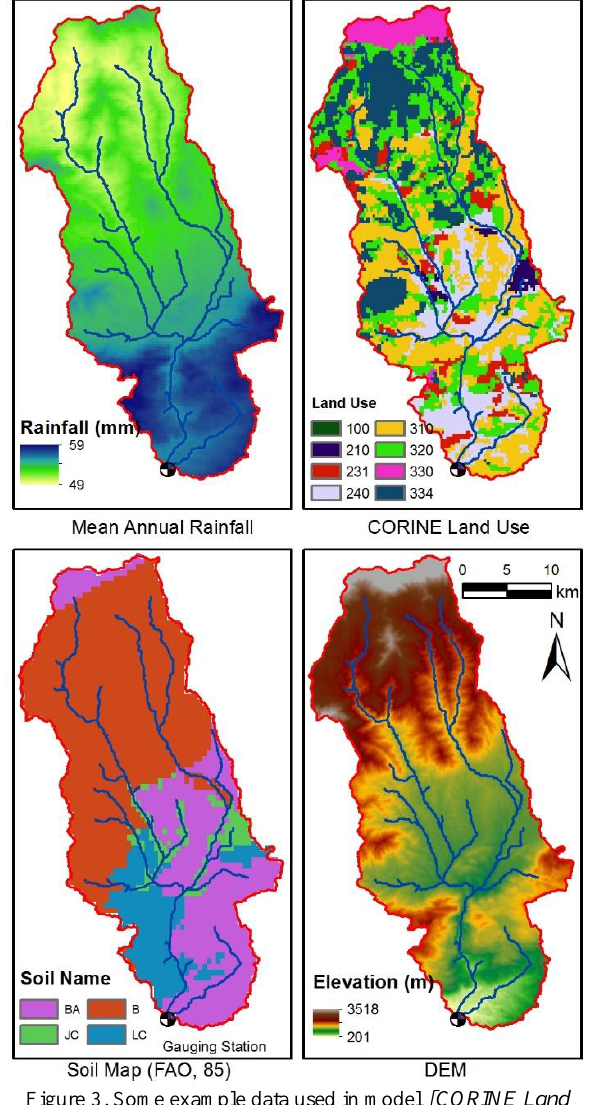
Figure 3. Some example data used in model [CORINE Land Cover Map (100: Artificial land, 210: Arable land, 231: Pastures and grassland, 240: Heterogeneous agricultural land, 310: Forests, 320: Scrubs, 330: Bare land 334: Degraded forests, 400; Water surfaces and wetland) Soil Name (BA: Calcaric Cambisol, B: Cambisol, JC: Calcaric Fluvisol,